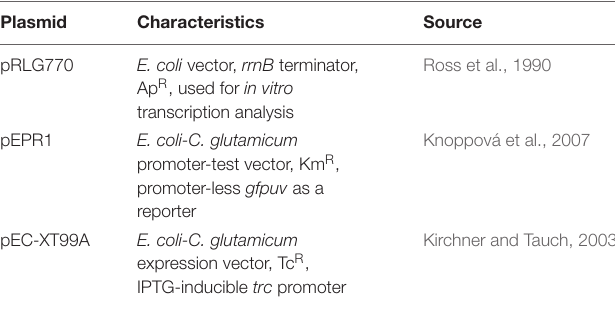
TABLE 1 | Plasmid vectors used in this study.